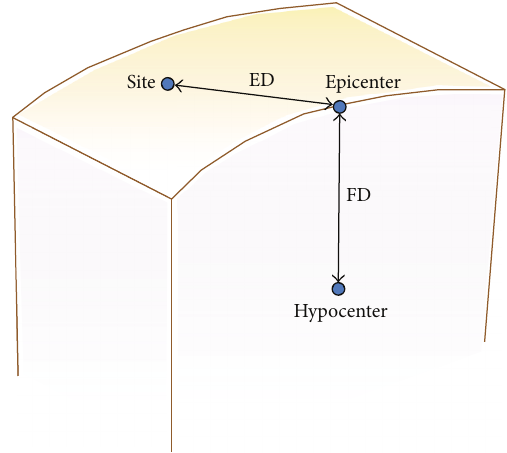
Figure 11: Schematic representation of parameters: focal depth, FD, and epicentral distance,